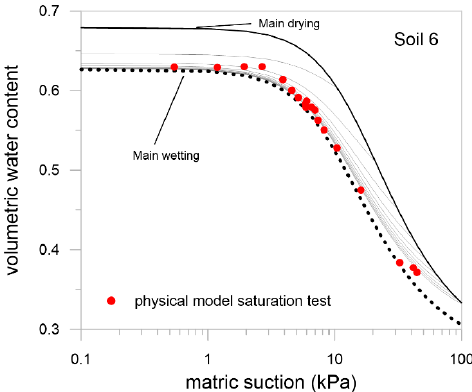
Figure 9. Comparison between the main loop obtained from the inverse analysis (main drying and main wetting) and the experimental data recorded during a full saturation test of the physical model performed at the end of the fourth hydrological year. Gray lines represent the theoretical paths determined by using Equation (2) for different initial suction levels on the main drying curve.